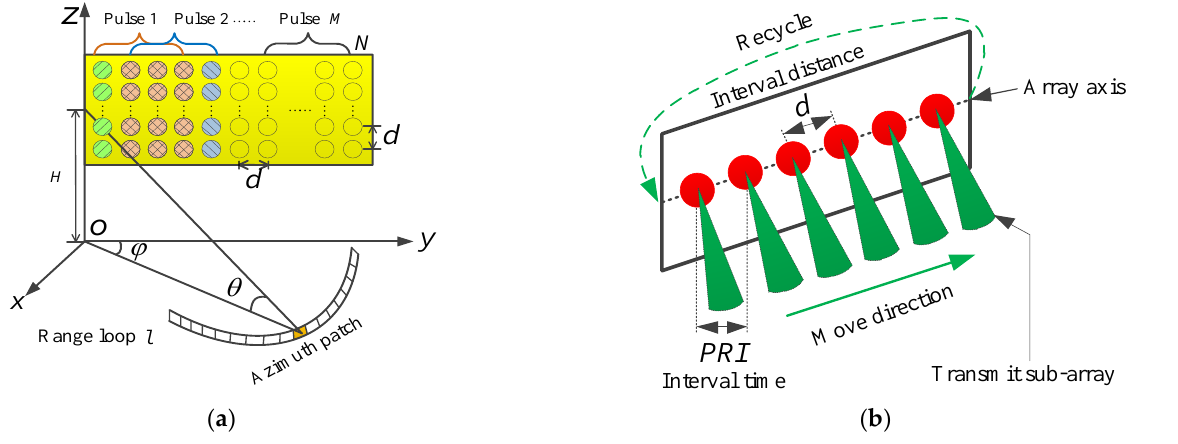
Figure 3. Schematic of transmit and receive phase centers.